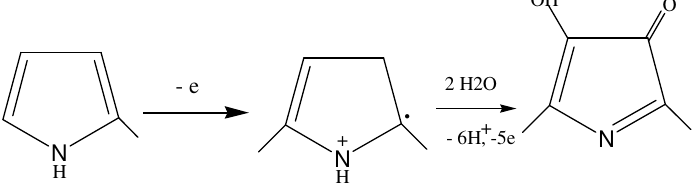
Figure 5. Proposed mechanism for anodic overoxidation of